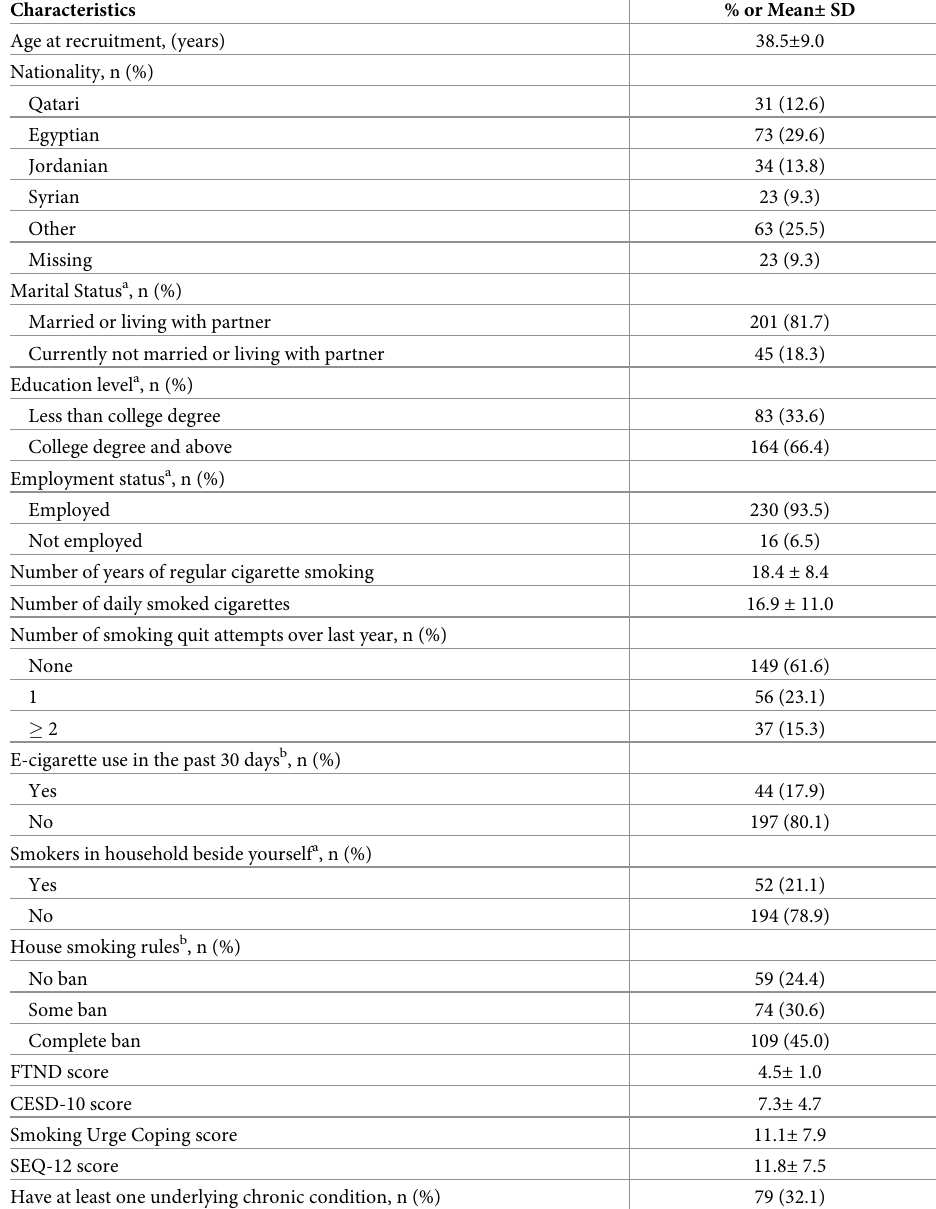
Table 1. Baseline characteristics of participants (n = 247) presented as mean ( ± SD) or frequency (%).